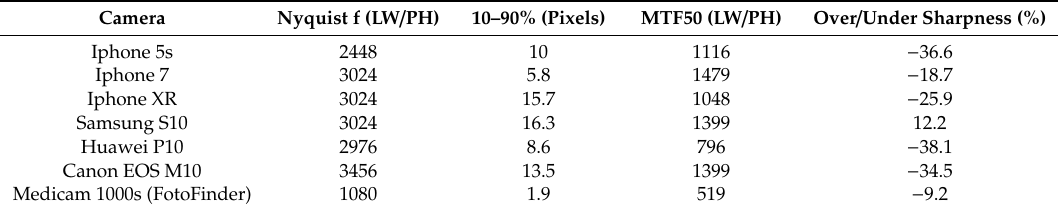
Table 3. Cameras with DermLite 4 DL dermoscope sharpness results—macro test chart.